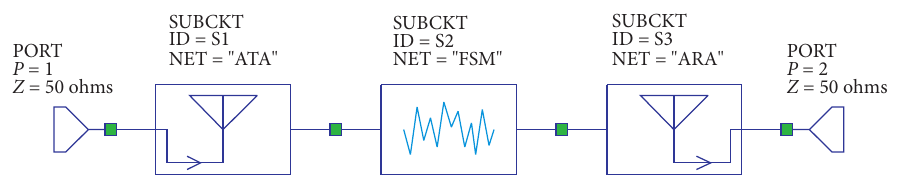
Figure 11: A two-port network associated with the wireless connection.